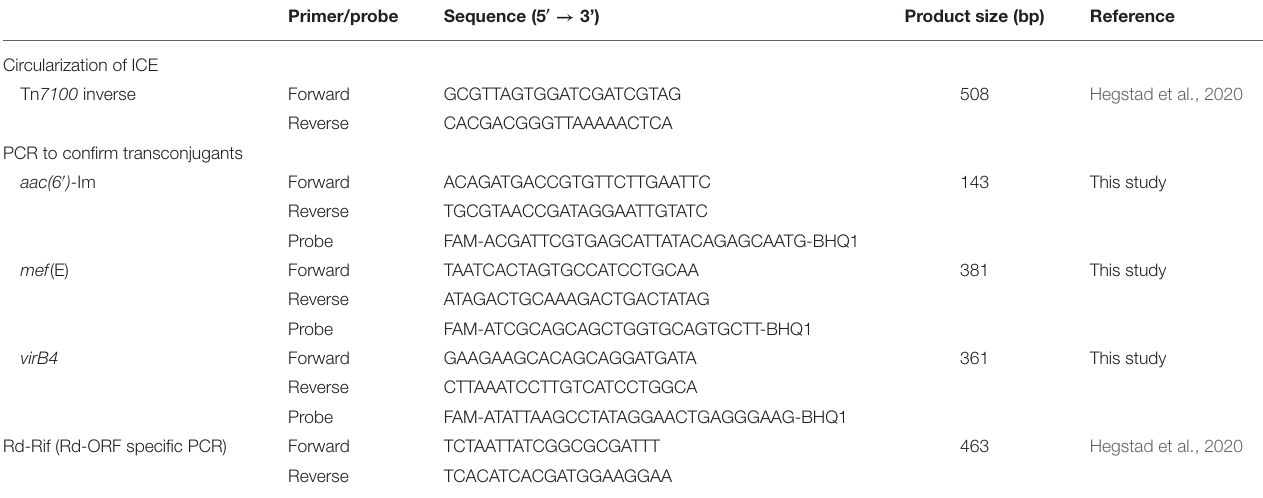
TABLE 2 | PCR primers and probes used in this